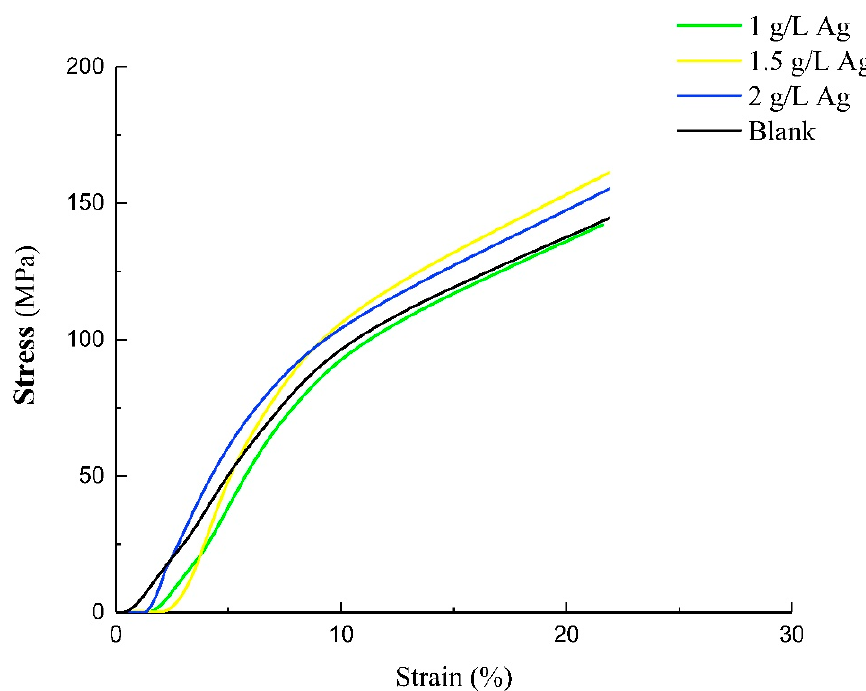
Figure 3. Stress vs. strain curves. Table 1. Mechanical properties of the PEO-treated and -untreated scaffolds.